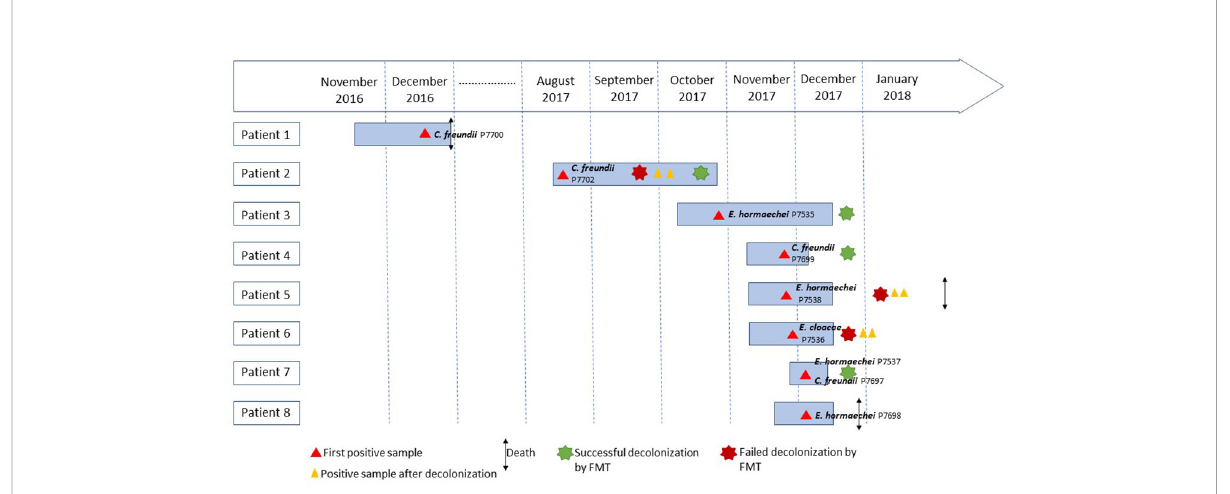
FIGURE 1 Timeline of patients with carbapenemase-producing